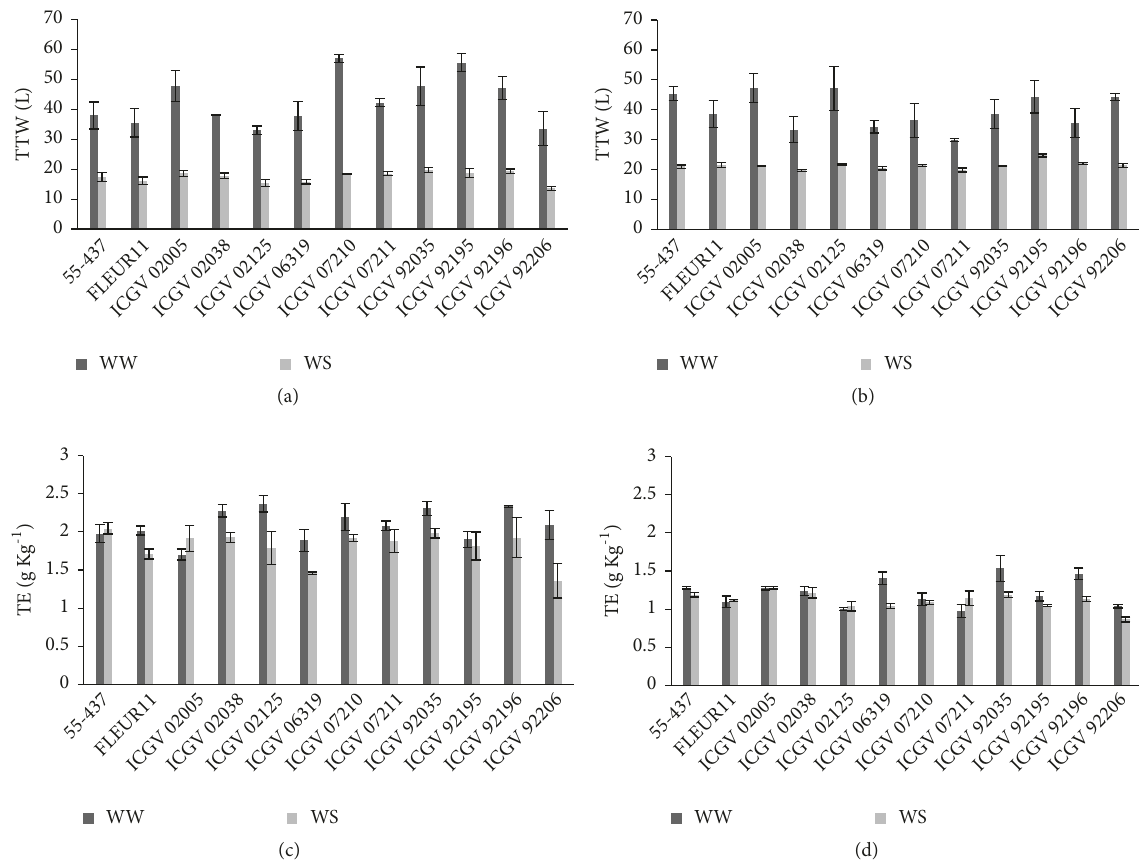
Figure 2: Total transpired water (TTW) and transpiration efficiency (TE) of groundnut genotypes under WW and WS treatments in year 1 ((a) and (c)) and year 2 ((b) and